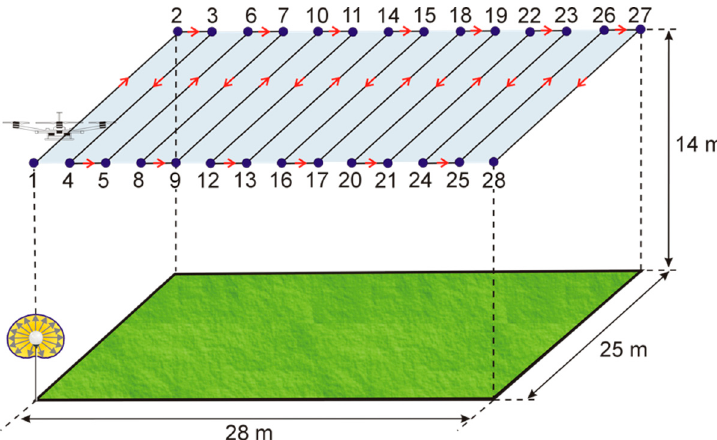
Figure 7. The UAV route on the planned measuring grid.